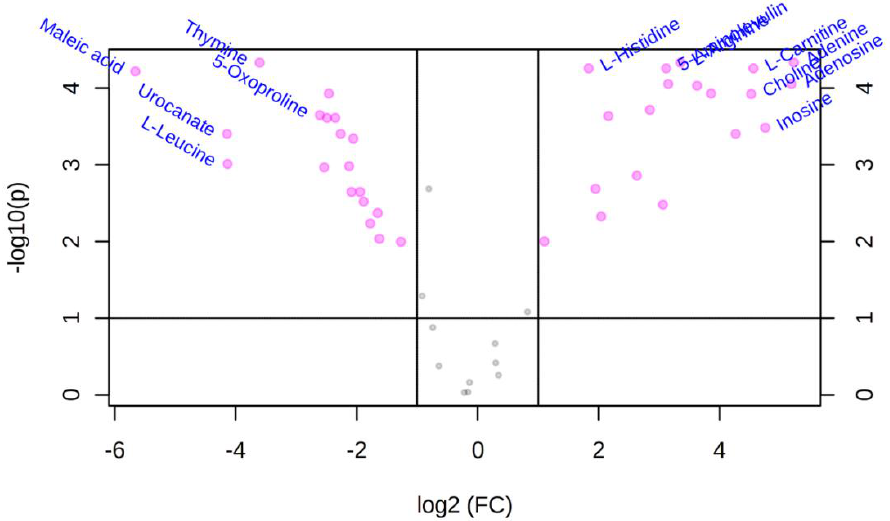
Figure 3. Volcano plot of untargeted metabolomics analysis of differential features (i.e., 49 MSI-I (Metabolomics Standard Initiative level-1) identified polar metabolites from somatic extracts) between the somatic extract of infective third-stage larvae (L3) of N. brasiliensis (NB_SE) and the somatic extract of T. muris embryonated eggs (TM_SE). The volcano plot displays log2 fold changes versus Benjamini–Hochberg adjusted p -values ( − log10 transformed). Features that exhibited an absolute log2 fold change > 2 and an absolute p -value < 0.05 are coloured in pink. Most significant metabolites are labelled with the corresponding